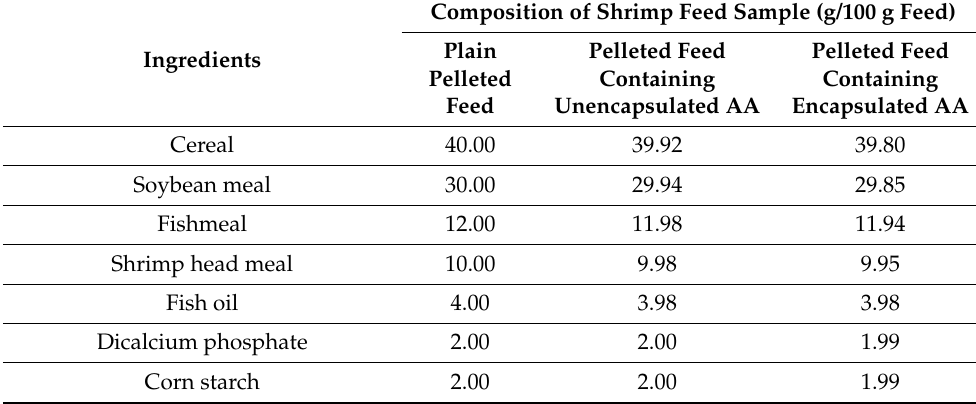
Table 1. Composition of the shrimp feed samples (dry